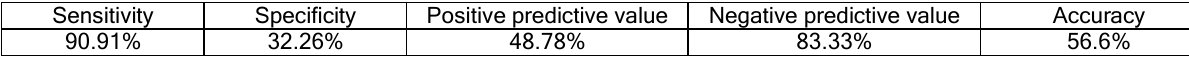
Table 5: Sensitivity, specificity, NPV, PPV and accuracy of hyperintensity on DWI. Sensitivity